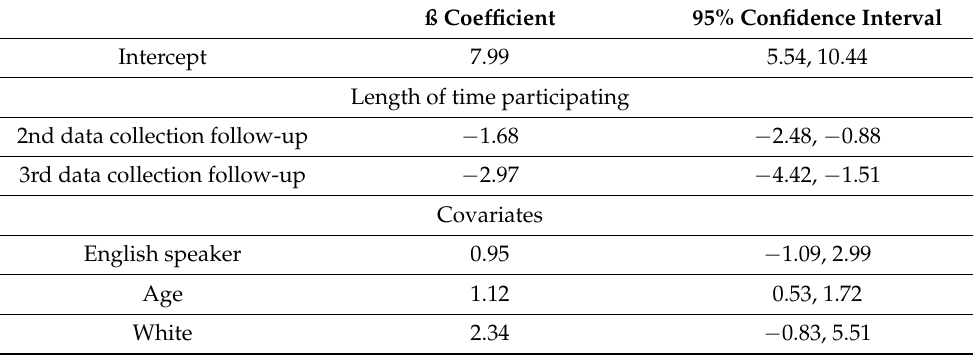
Table 3. Association between care-related covariates and emotional and behavioral functioning score using a random-effects maximum likelihood estimation regression among children with more than one recorded observation in 2010 (148 individuals, 313